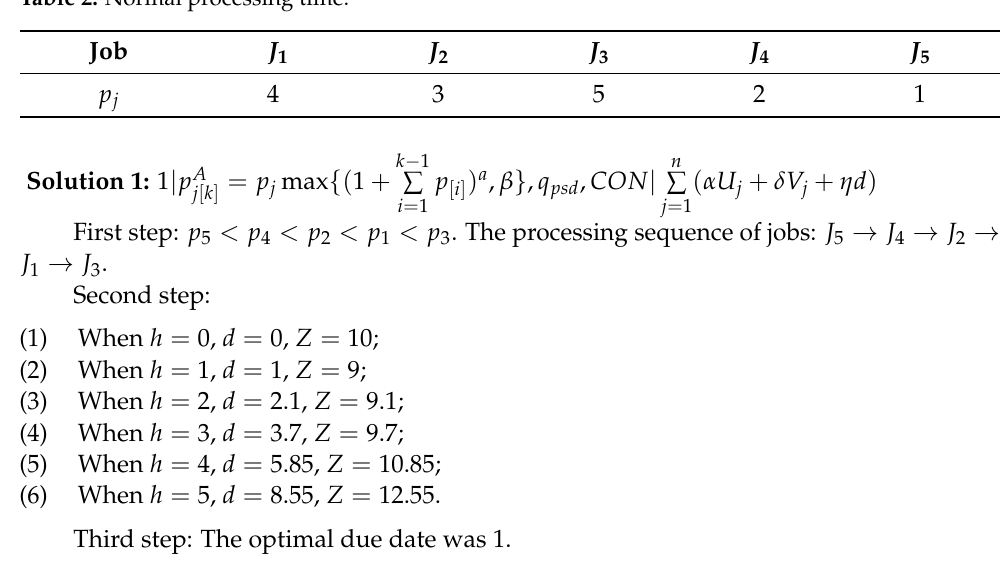
Table 2. Normal processing time.